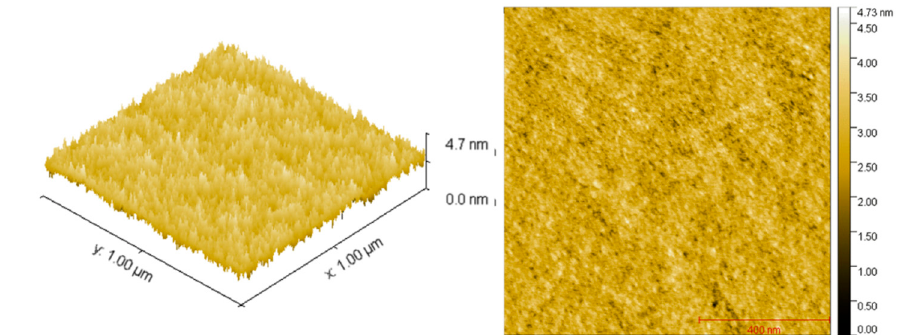
Figure 2. Atomic force microscopy images of the DPP-T-TT film deposited by spin coating and measured using tapping mode.